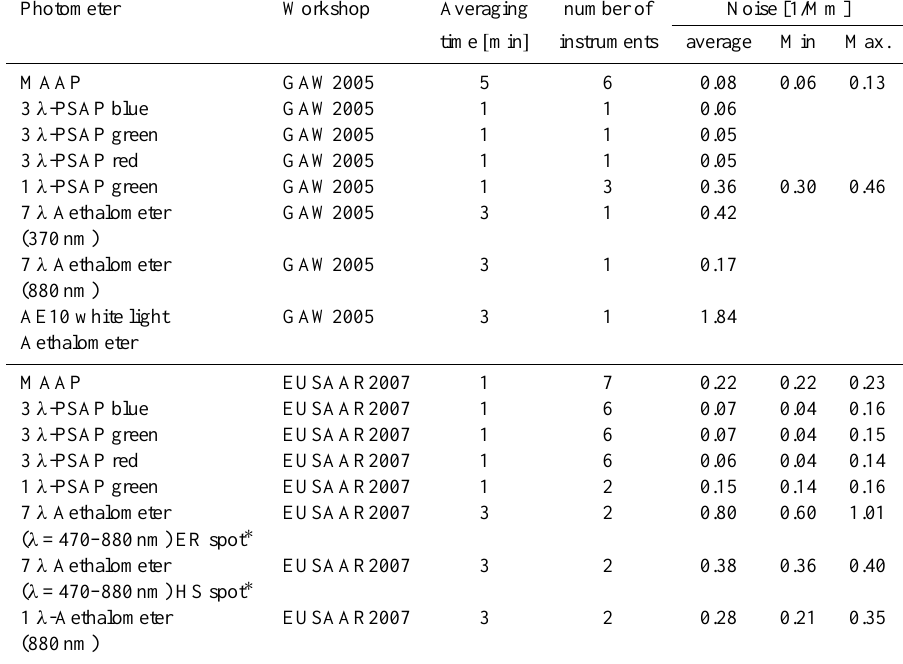
Table 9. Instrumental noise measured during the workshops for different photometer types. Photometer